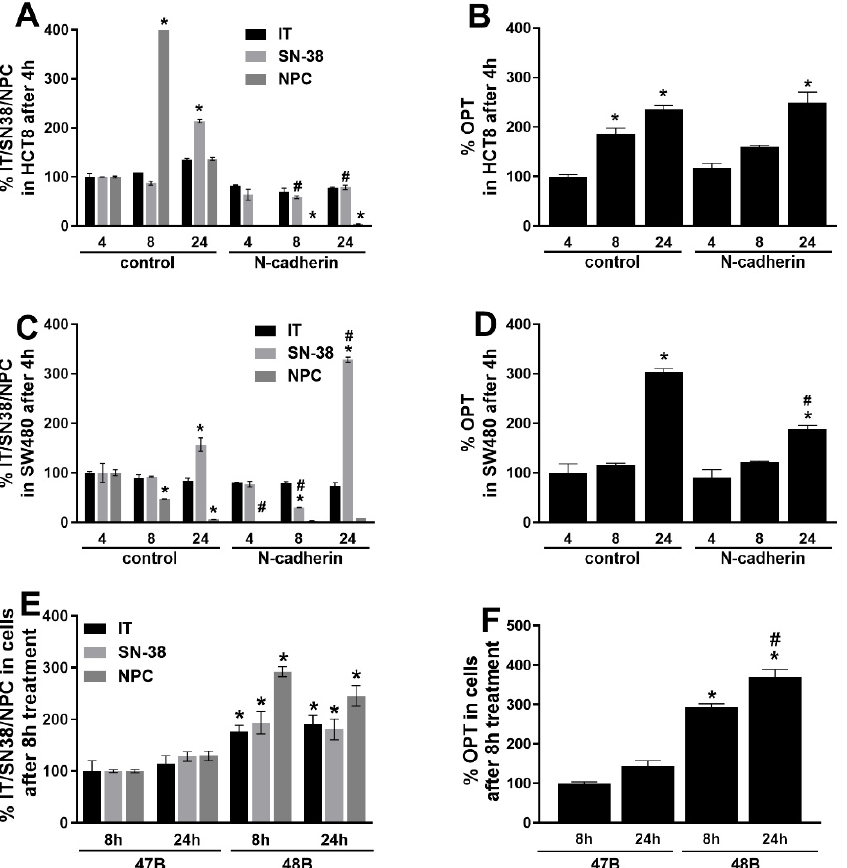
Figure 2. LC-MS analysis of irinotecan (IT) and its metabolites SN-38 and NPC, resp. oxaliplatin (OPT) inside the cells with different levels of N-cadherin: ( A ) amount of IT, SN-38 and NPC inside HCT8 and its N-cadherin plasmid-transfected variant; ( B ) amount of OPT inside HCT8 and its N-cadherin plasmid-transfected variant; ( C ) amount of IT, SN-38 and NPC inside SW480 and its N-cadherin plasmid-transfected variant; ( D ) amount of OPT inside SW480 and its N-cadherin plasmid-transfected variant; ( E ) amount of IT, SN-38 and NPC inside derived primocultures 47B (with naturally higher N-cadherin level) and 48B (with naturally non-N-cadherin level); ( F ) amount of OPT inside derived primocultures 47B (with naturally higher N-cadherin level) and 48B (with naturally non-N-cadherin level). The data are expressed as percentage of IT, SN-38, NPC or OPT inside the cells per mg of protein. Amount of all tested drugs was determined by LC/MS analysis. Measurements were performed in two independent experiments. * p < 0.05 8 h, resp. 24 h time interval vs. 4 h time interval (24 h vs. 8 h time interval in 47B and 48B cells); # p < 0.05 N-cadherin plasmid treated vs. untreated cells.